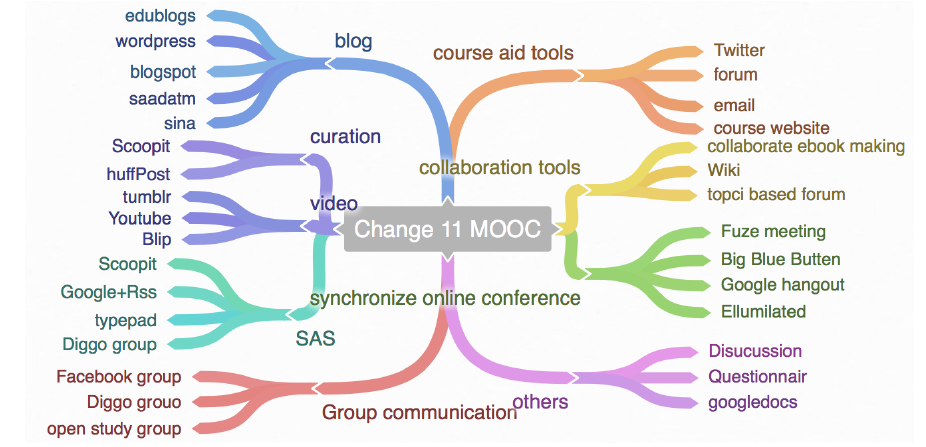
Figure 2. Technology learner used to support their learning in Change 11